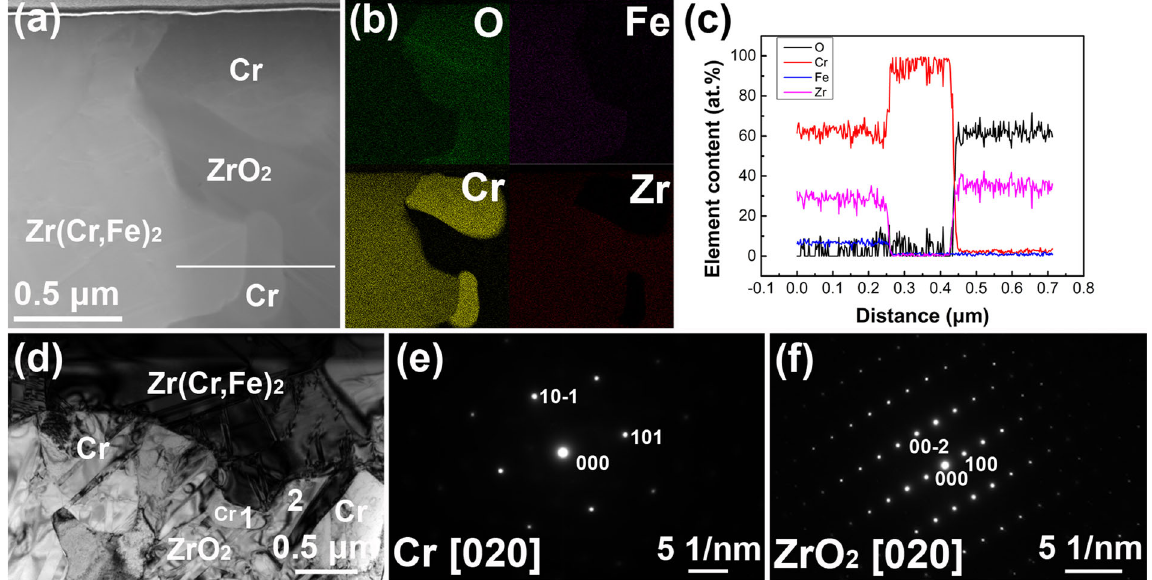
Fig. 8 Microstructures and compositions at the interface of layers 7/8 in Fig. 4. a HAADF and d TEM image of Zr(Cr,Fe) 2 , Cr and ZrO 2 , and corresponding b EDS mappings and c EDS line scan; SEAD patterns of e Cr and f ZrO 2